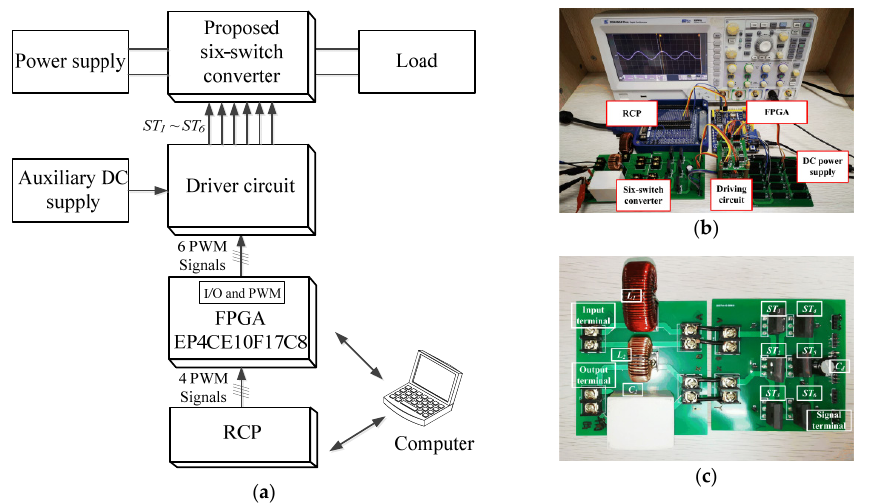
Figure 11. ( a ) Block diagram of the experimental system; ( b ) Experimental set up; ( c ) Top-view of prototype.